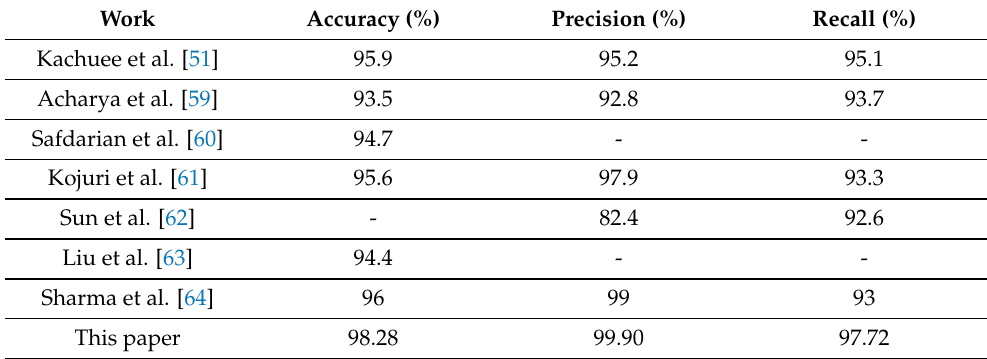
Table 6. Comparative results in the PhysioNet PTB Myocardial Infarction